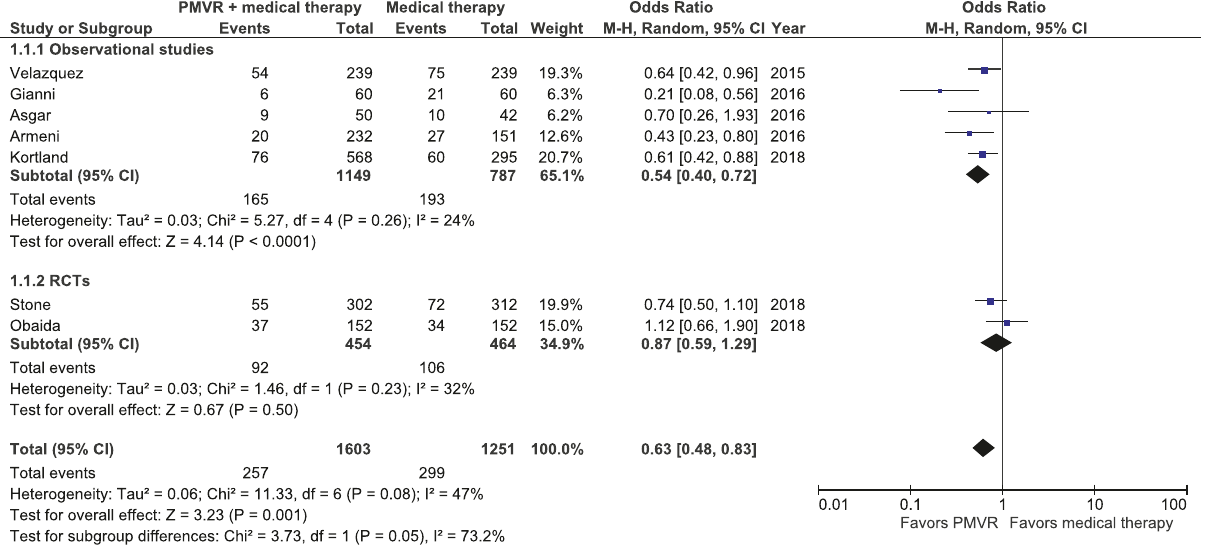
Figure 2: Forest plot displaying the risk of 1-year mortality in the PMVR group compared to the OMT group.